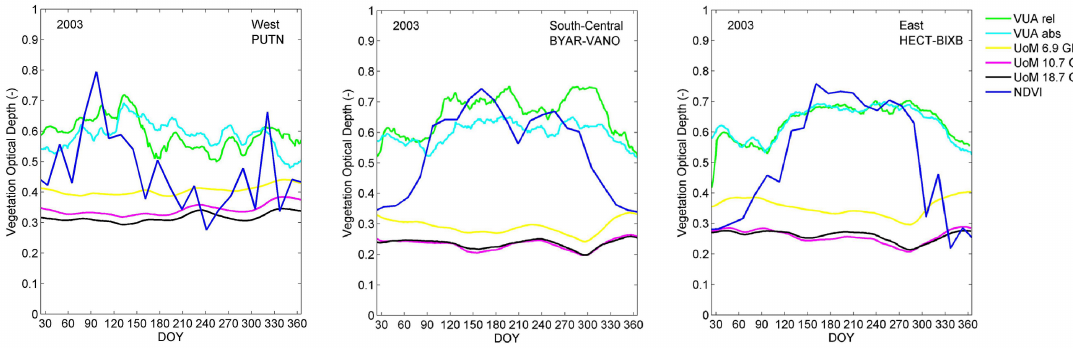
Fig. 6. The AMSR-E UoM and VUA VOD retrievals (low-pass filter 30 days), together with area-averaged NDVI.